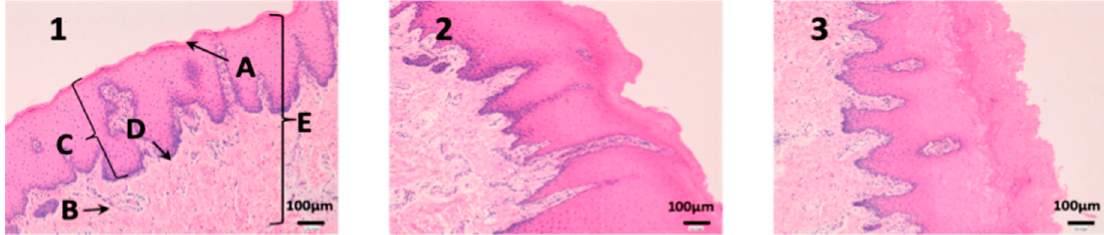
Figure 8. Photo 1: Histological image of untreated buccal mucous observed at 400×; Photo 2: Histological image of buccal mucous treated with CP-Solution observed at 400×; Photo 3: Histological image of buccal mucous treated with CP-NPs observed at 400×. (A) Stratified flat keratinized epithelium; (B) own laminate. (C) dermal papilla; (D) basal layer and (E) buccal mucous.